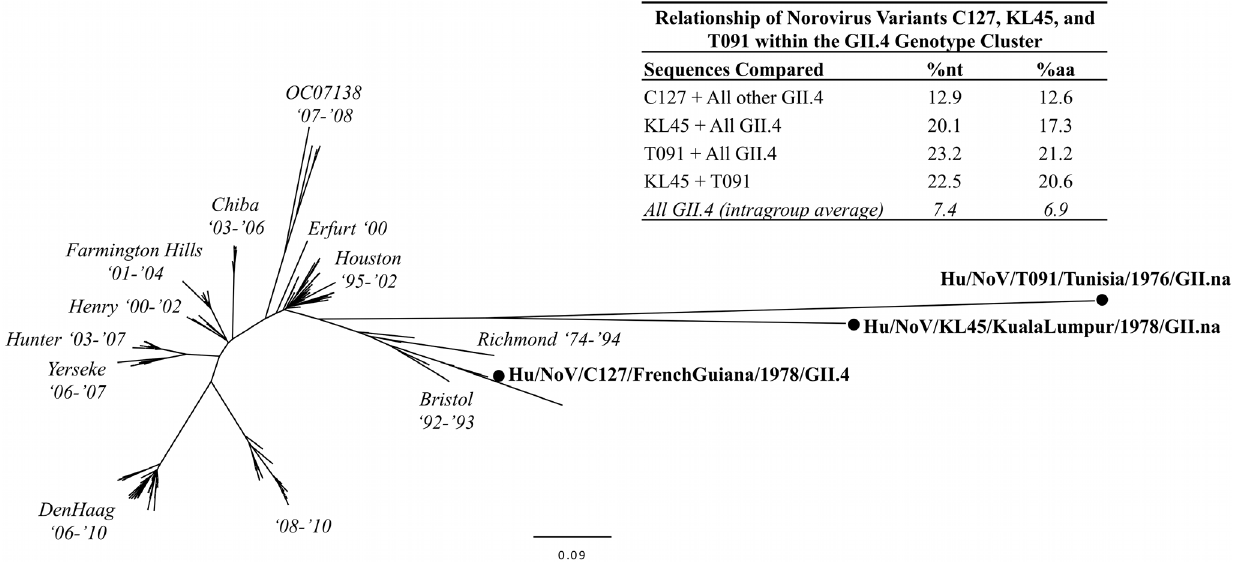
Figure 5. Maximum likelihood phylogenetic analysis of full-length VP1 capsid nucleotide sequences from all GII.4 variant clusters (n=162 sequences). Variant clusters described by Zheng et al. are indicated in italics along with their associated years of specimen collection. A new cluster was defined (‘‘08–10’’), which contains strains obtained from the United States, Australia, Europe, Asia, and Africa. Percent nucleotide and amino acid distances are provided in an inlaid table. These distances were determined from a multiple sequence alignment containing all known GII.4 nucleotide sequences available in GenBank as of April 2012 (n=663 sequences). An average intragroup distance was calculated for all GII.4 sequences, excluding the unique genogroup GII variants KL45 and T091.